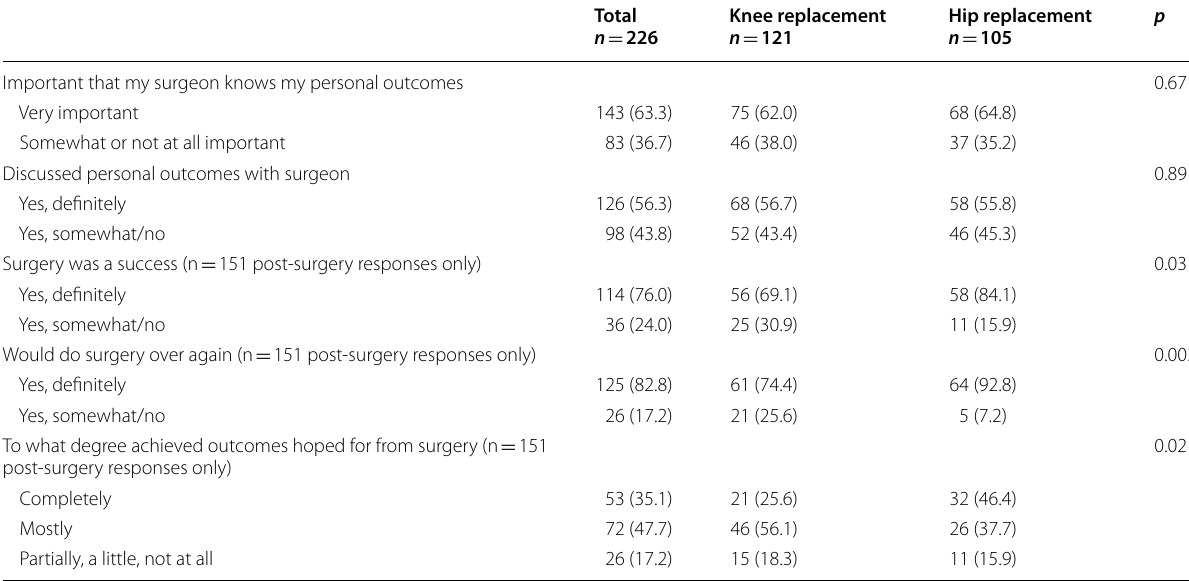
p value from Pearson chi-square